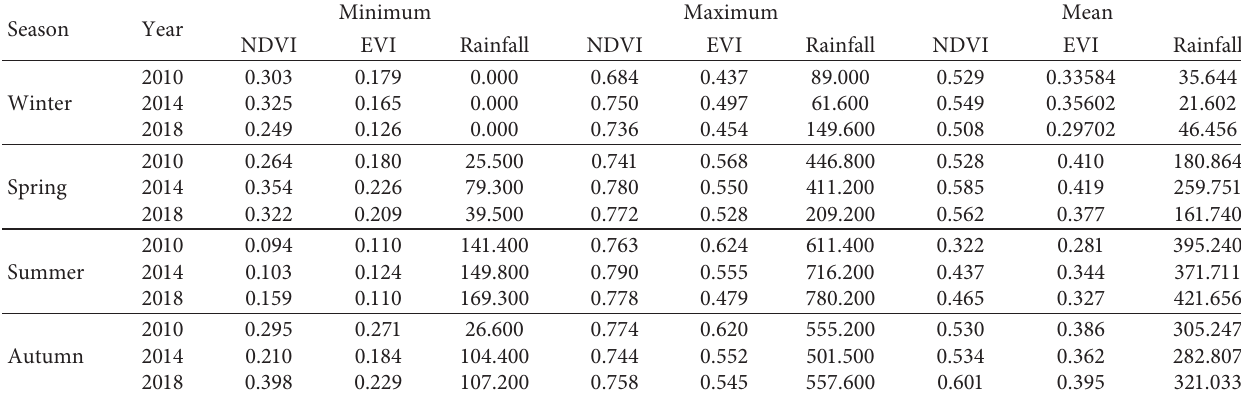
Table 1: Yearly seasonal variation of vegetation indices.